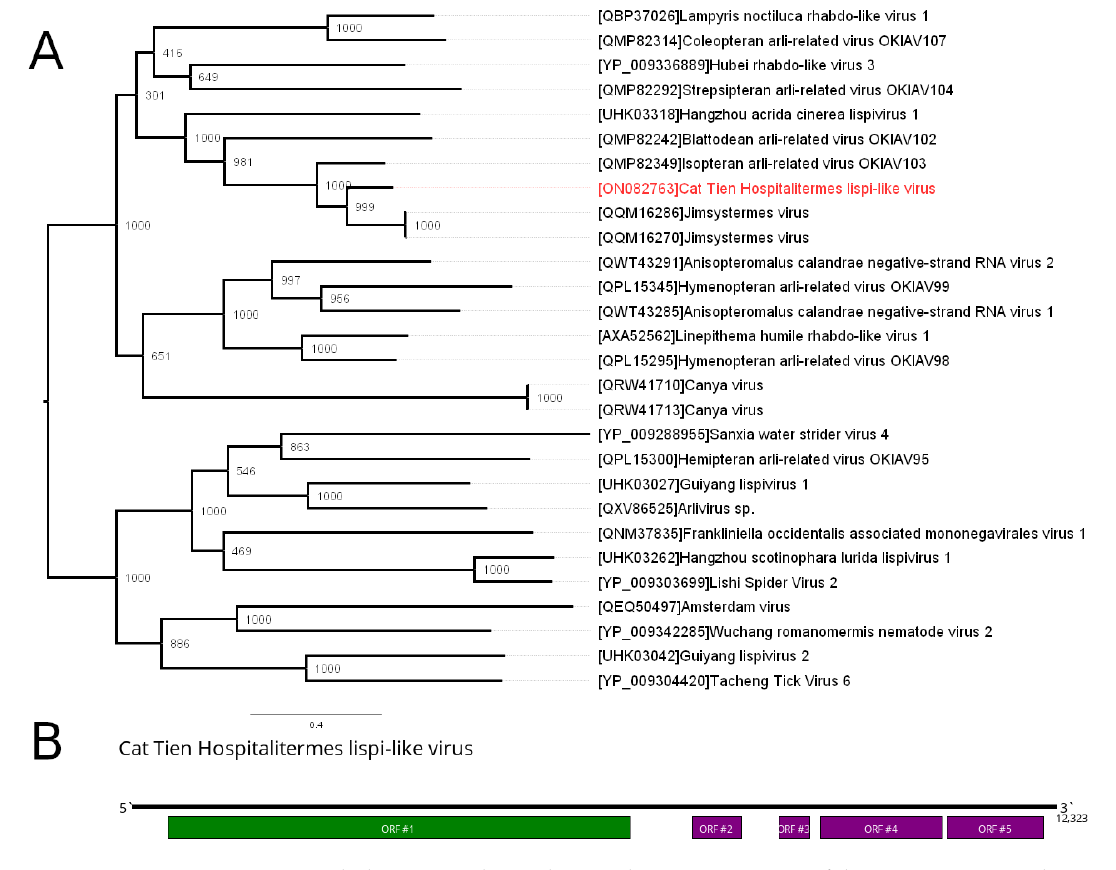
Figure 2. Phylogenetic relationships and genetic structure of the Cat Tien Hospitalitermes lispi-like virus (CHLV). ( A ) Phylogenetic relationships of the CHLV. Analysis was performed using amino acid sequences of viral polymerases, with 1000 bootstrap replicates. Tree is midpoint-rooted for the clarity only. Bootstrap support values are shown for each node. Scale bar represents the number of amino acid substitutions per site. CHLV is marked red. ( B ) Scheme of the CHLV genome, with RNA-dependent RNA polymerase is marked in green.